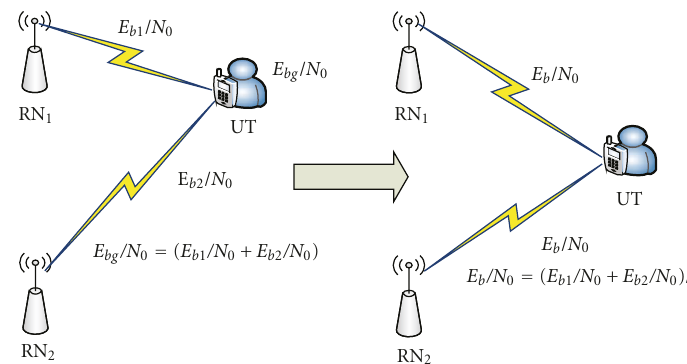
Figure 2: Nonsymmetrical (left) and symmetrical (right) DSFC topologies with two